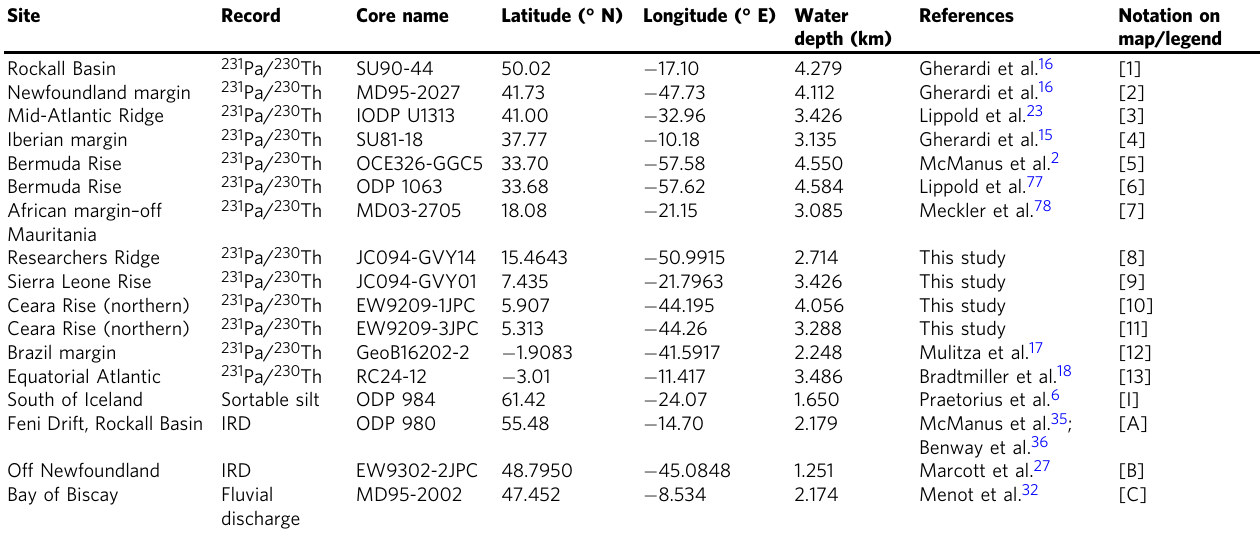
Table 1 Summary of sediment cores used to discuss deglacial changes in AMOC and ice sheet system Site